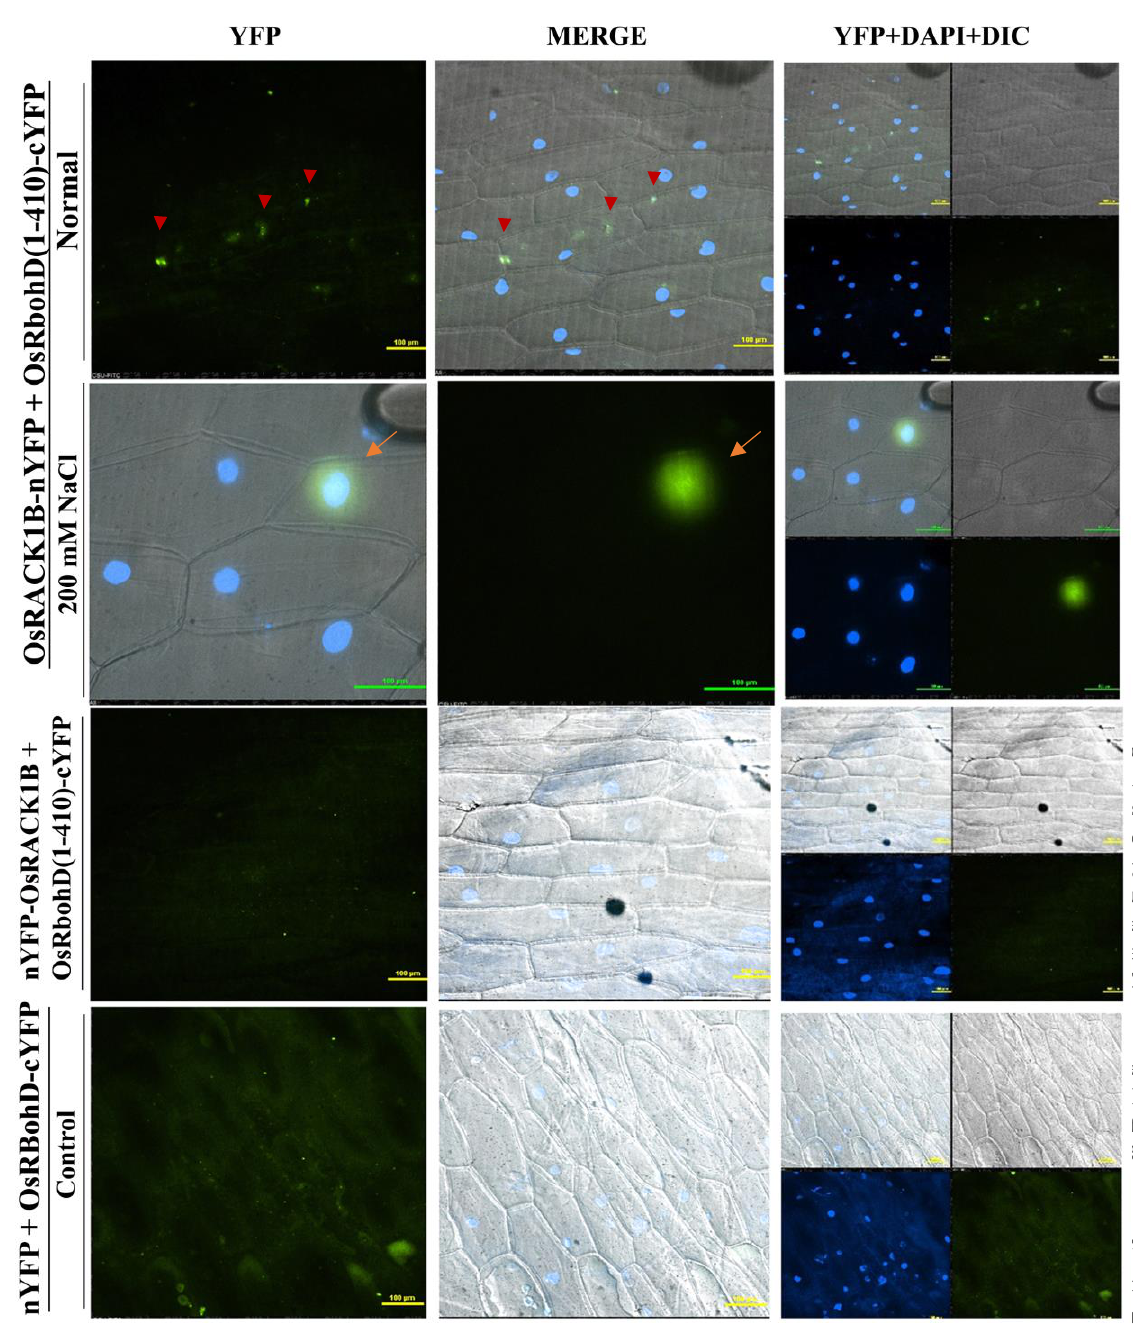
Figure 4. Visualization of OsRACK1B and OsRbohD interactions using bimolecular fluorescence complementation (BiFC) assay. OsRACK1B interacts with the N-terminus of OsRbohD inside the cytoplasm (red arrowhead) under normal conditions (top panel) and inside the nucleus (orange arrow) in the presence of salinity stress (second panel). In the control, the coexpression of OsRACK1B and OsRbohD (1-410 aa) constructs showed DAPI fluorescence but no YFP signals (bottom two panels). The onion epidermal cells were transiently transformed with the full-length OsRACK1B cds and N-terminal region of OsRbohD consisting of 1 to 410 amino acid sequences. Blue